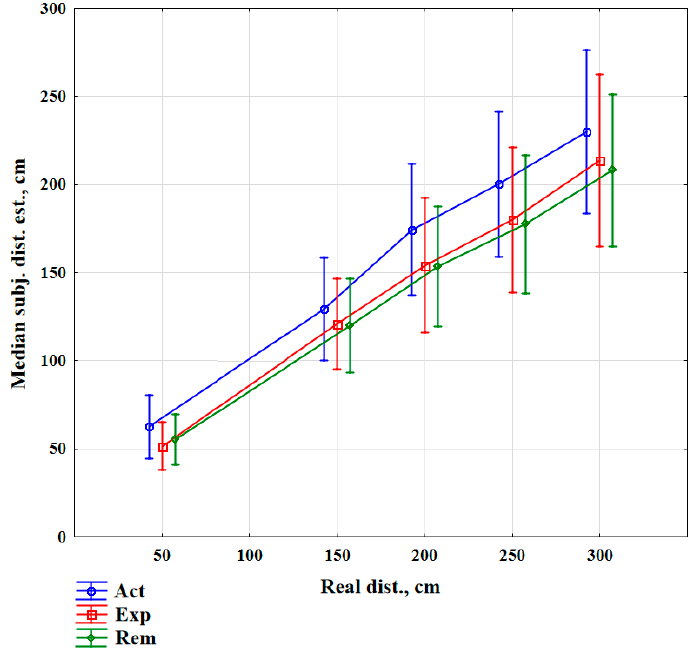
Figure 3. Group means of median subjective estimates in three experimental conditions. Vertical lines denote 95% confidence intervals.